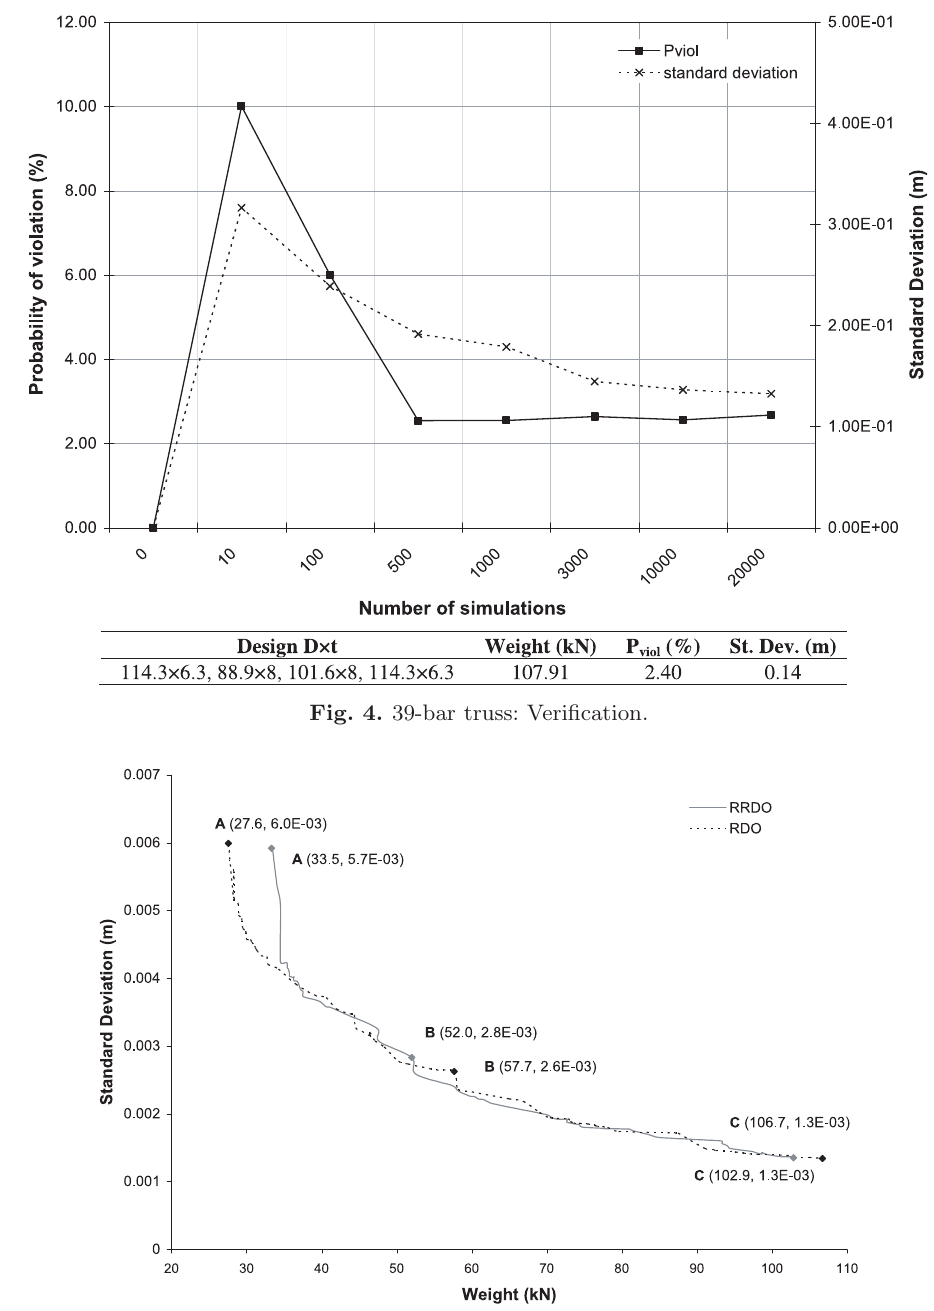
Fig. 5. 39-bar truss: Comparison of the Pareto front